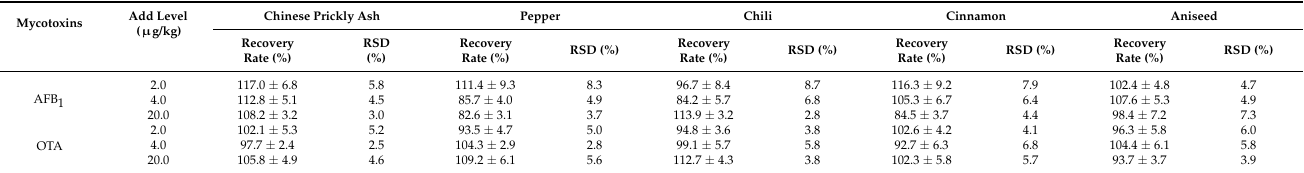
Table 7. HPLC addition recovery rate and relative standard deviation.